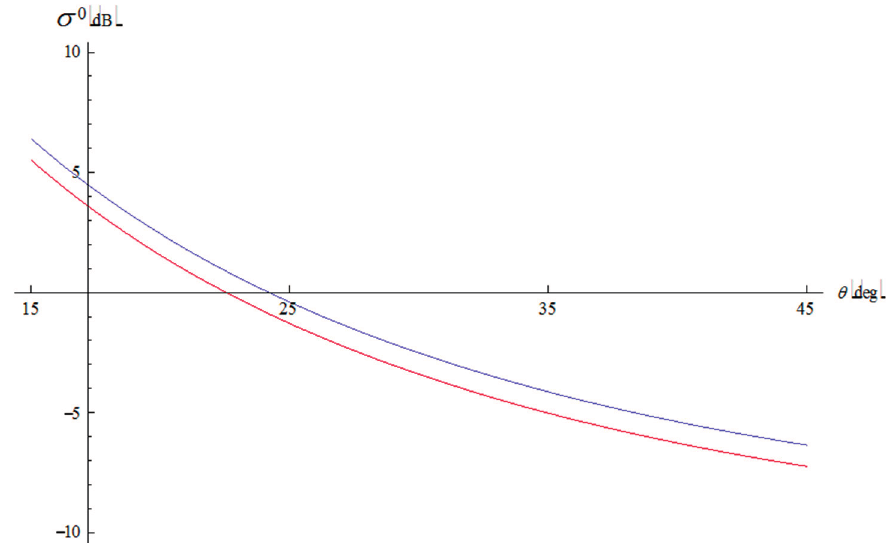
Figure 6. Backscattering coefficient from a rough terrain as a function of the incidence angle, evaluated with the SPM at X- (blue line) and C- (red line) bands.